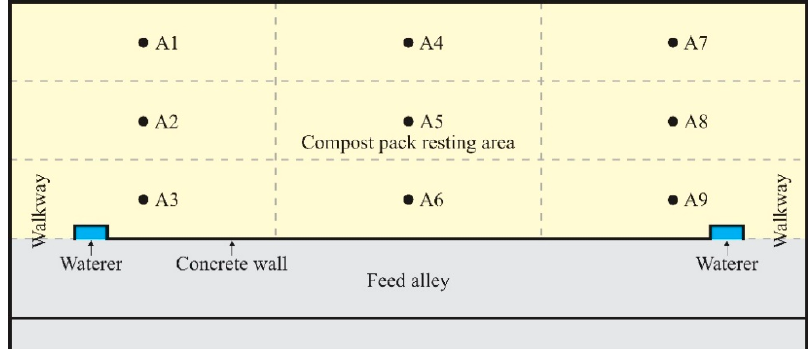
Figure 1. Nine grid spaces (A1 to A9) of sample collections inside the CBP barns.